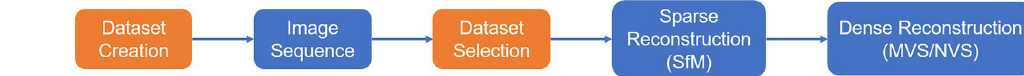
Fig. 8 The reconstruction flowchart with the proposed dataset improvement methods (in orange color)